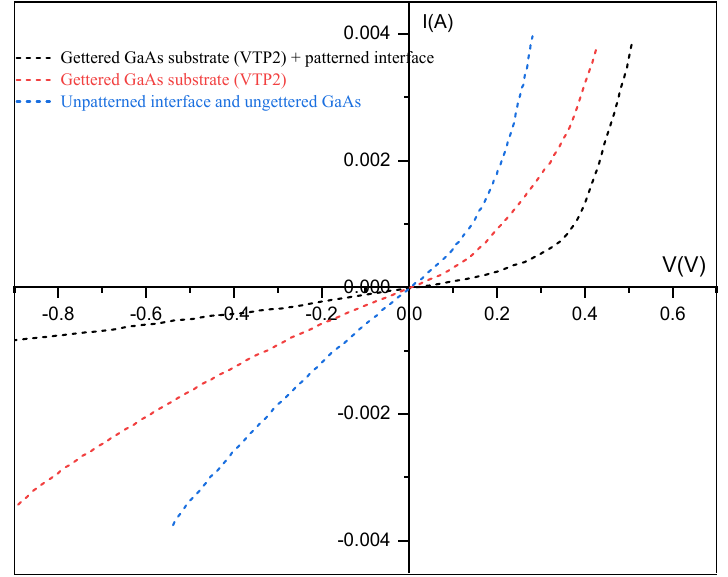
Figure 7. The I-V characteristics that were measured for three heterojunctions: Reference sample without any treatment, sample without microgrooves but gettered GaAs substrate, sample that was prepared with a gettered GaAs substrate (VTP2) and microgrooved interface.